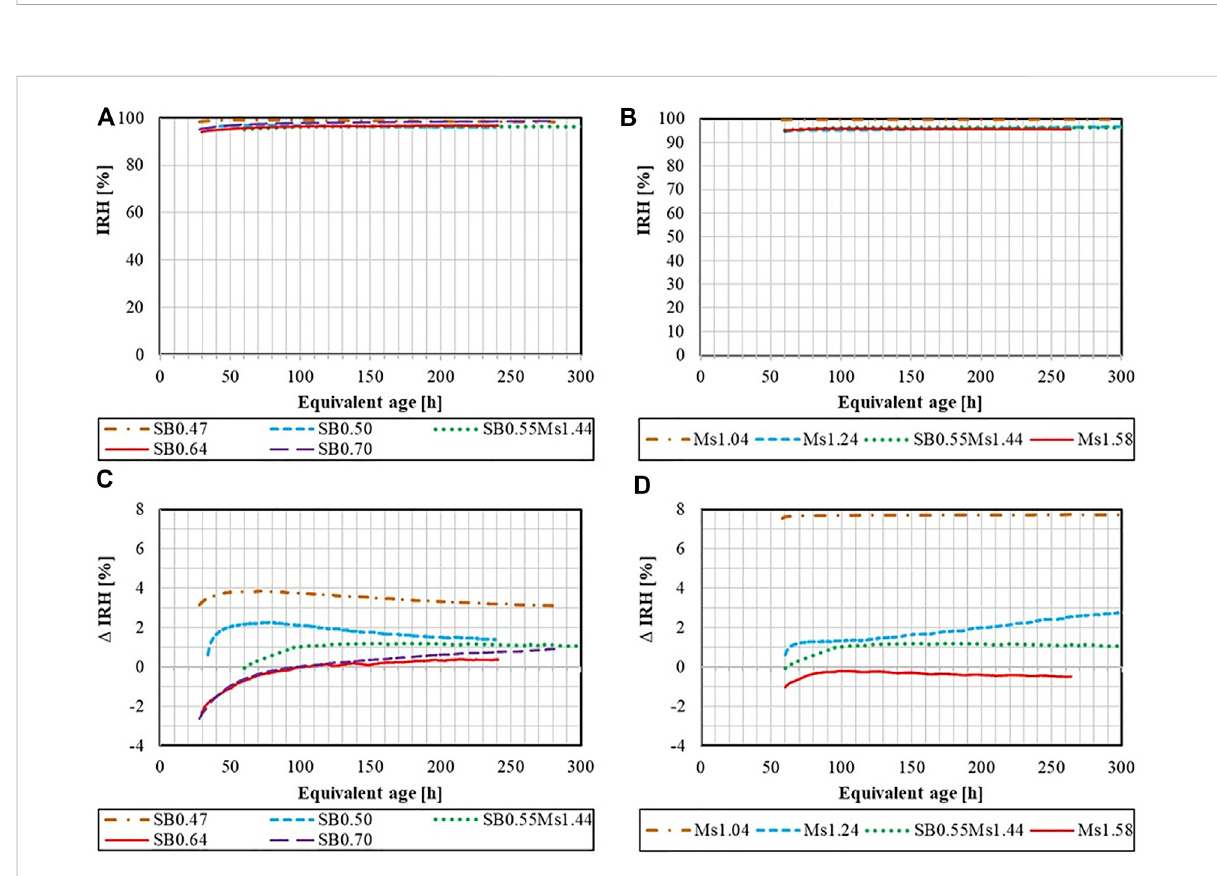
FIGURE 8 Internalrelativehumidity(IRH)ofAASFpasteswithdifferentS/B (A) andwithdifferentM s (B) ;IRHdifference Δ IRH(measuredRHaboveactivator solution subtracted from the measured IRH evolution of the paste) of AASF pastes with different S/B (C) and with different M s (D)